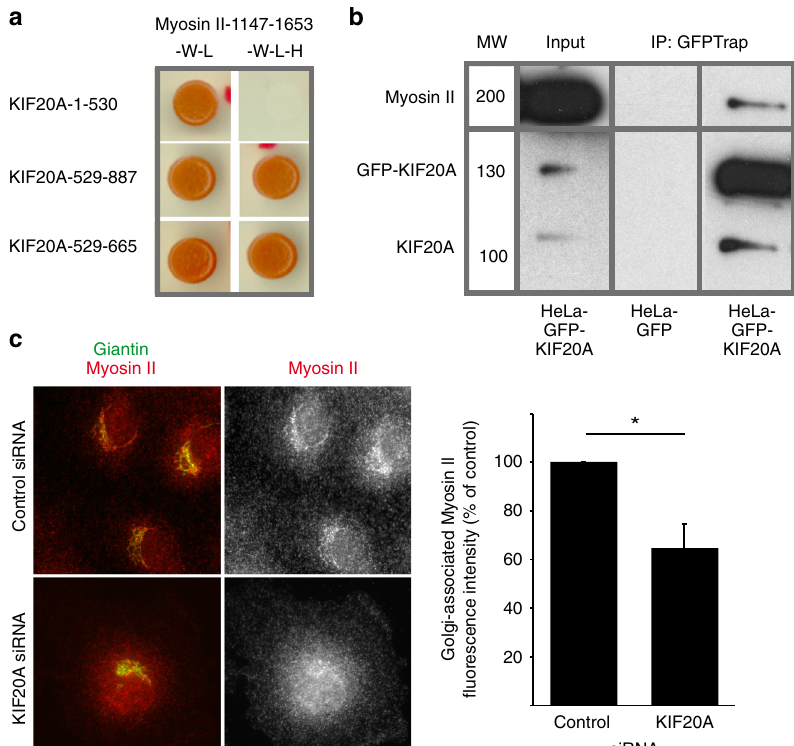
Fig. 3 KIF20A interacts with Myosin II and stabilizes Myosin II at the Golgi. a Yeast two-hybrid interactions between the tail domain of Myosin II (1147 – 1653 fragment) and different domains of KIF20A. The Saccharomyces cerevisiae reporter strain L40 was co-transformed with a plasmid encoding fusion proteins to detect interactions between amino acids 1147 and 1653 of human myosin IIA heavy chain and the motor domain (1 – 530), the tail domain (529 – 887), and the RAB6 binding domain (RBD) (529 – 665) of KIF20A. Growth on medium lacking histidine (-W -L -H) indicates an interaction between the encoded proteins. b Endogenous Myosin II is pulled-down by GFP-KIF20A. GFP-KIF20A or GFP-transfected HeLa cell extracts were immunoprecipitated using the GFP-trap system. Myosin II bound to GFP-KIF20A was revealed by western blot analysis using anti-Myosin II antibody. GFP- KIF20A and KIF20A were revealed by anti-KIF20A antibody. Note that endogenous KIF20A is found in the IP fraction because it likely can form dimers with GFP-KIF20A. Input represents a 5% load of the total cell extracts used in all conditions. c Staining for endogenous Giantin (green) and endogenous Myosin II using the AD7 antibody (red) in Rat Clone 9 cells 3 days after transfection with speci fi c KIF20A siRNAs. Bar, 10 µ m. Of note, KIF20A is required for cytokinesis and KIF20A depletion leads to binucleated cells 56,57 . Quanti fi cation of Golgi-associated Myosin II fl uorescence intensity in cells treated as described above (mean ± SEM, n = 23 – 66 cells). * P = 0.02 (Student ’ s t test). MW molecular weight in